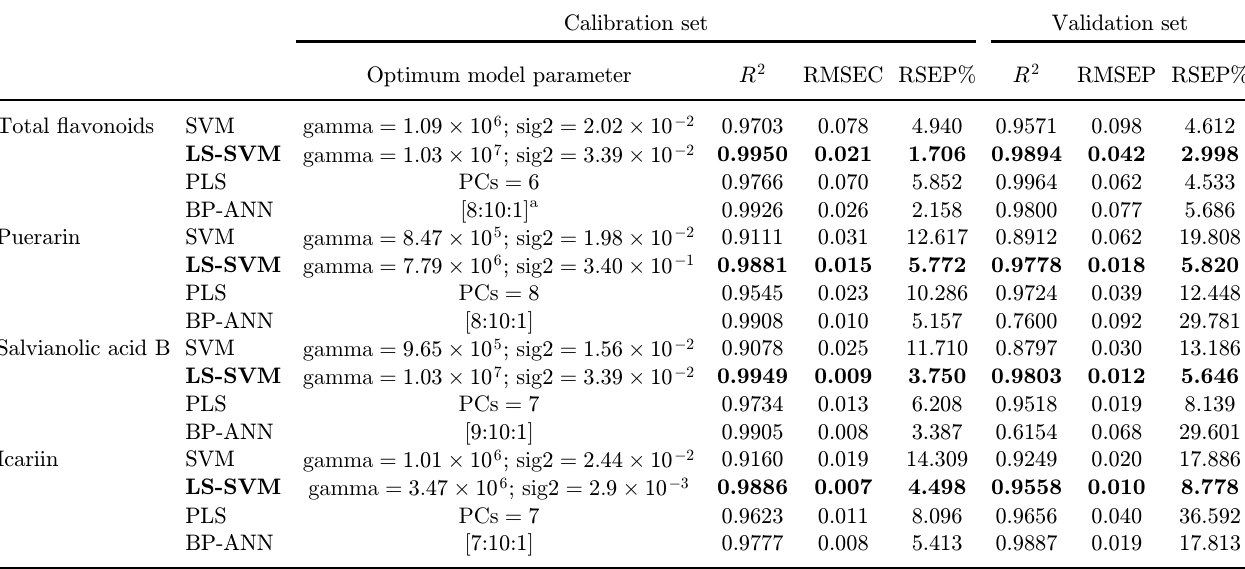
Table 1. Statistics of the optimal models using SVM, LS-SVM, PLS and BP-ANN methods. Calibration